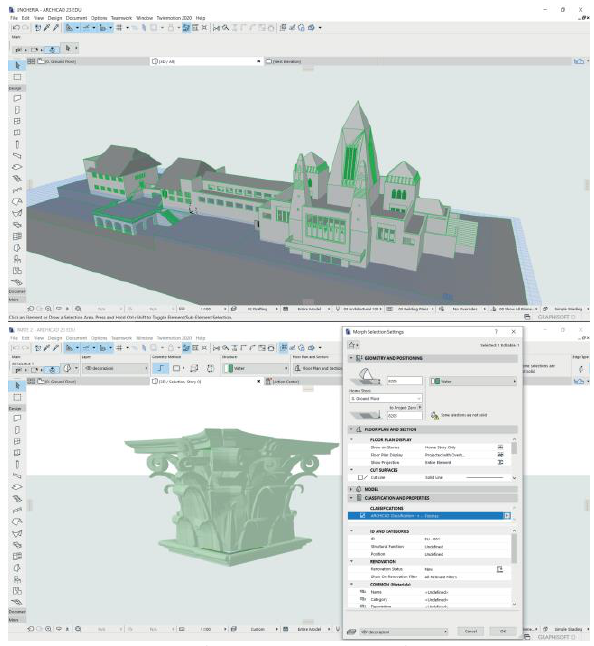
Figure 18. First test for the transposition of the non-parametric 3D model into a parametric 3D model: (up) the simple case of the Pavilion of Hungary, (down) the partial parametrization of a complex capital of the Monumental complex